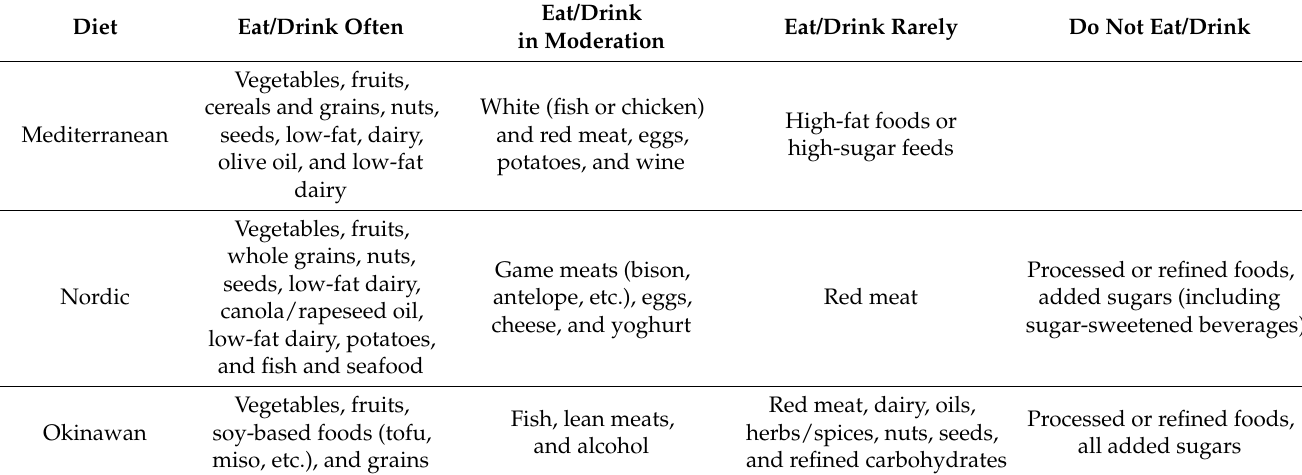
Table 1. Dietary constituents of the Mediterranean, Nordic, and Okinawan